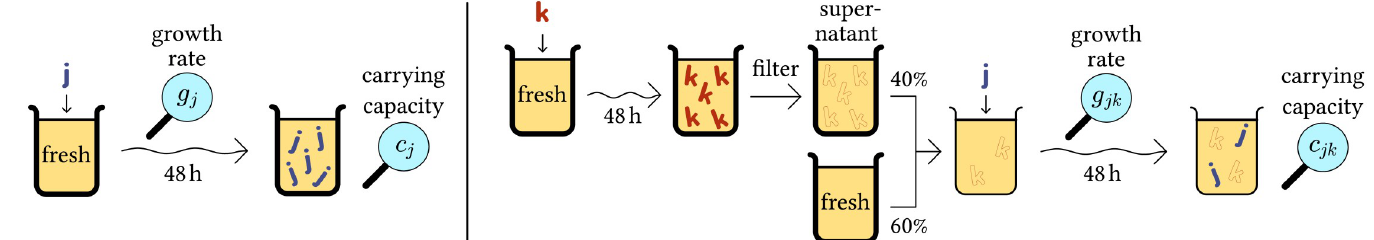
Fig 4. Acquisition of data used in our case study. Measurement of growth characteristics (left) and pairwise interactions (right) of bacterial strains isolated from urinary-tract infections [16]. Left: Each strain j was cultivated for 48 h in artificial urine. Solid bold letters represent individuals of the respective strain. The exponential growth rate g j as well as the carrying capacity c j (named yield in the original study [16]) were experimentally determined via optical densities. Right: For each strain k , a conditioned medium was produced by letting the strain grow for 48 h, mechanically removing the bacteria to obtain a supernatant , and mixing the result with fresh medium in a ratio of v ≔ 0.4. Outline letters (“footprints”) indicate to what extent the respective culture consists of supernatant. In each such medium, each strain j was cultivated, and the conditioned growth rate g and carrying capacity c were determined as jk jk